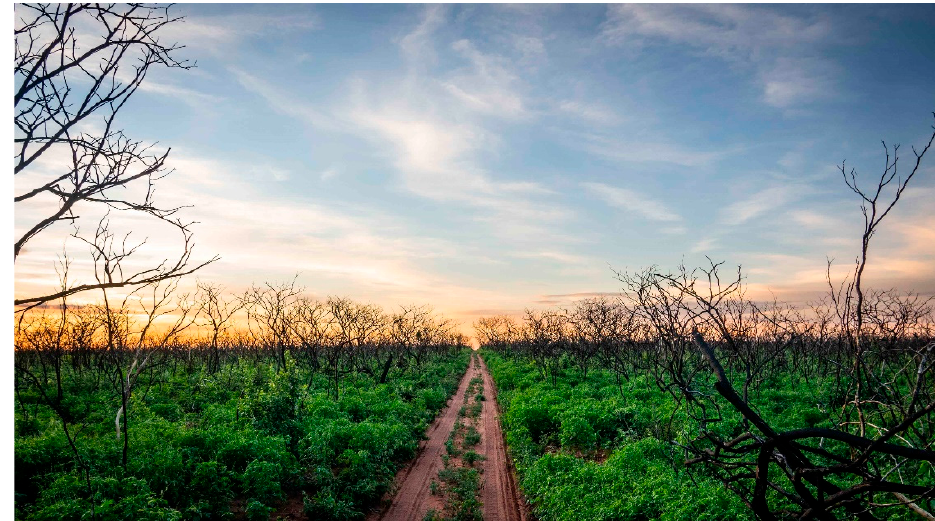
Figure 2. Abayoy, a scrubland formation impacted by fires in 2019 in the process of regeneration, indigenous Ñembi Guasu Protected Area of Conservation and Ecological Importance, Department of Santa Cruz (Photo: H. Azurduy).